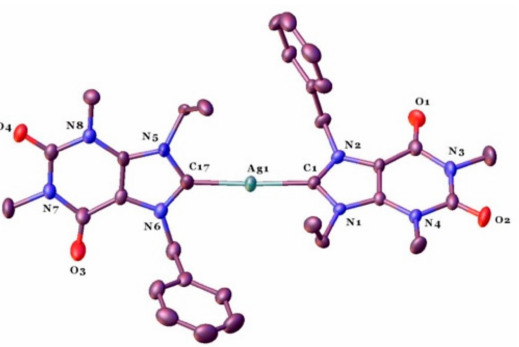
Figure 2. Molecular structure of compound 7 . Thermal ellipsoids are drawn at the 50% level. Hydrogen atoms and the PF 6 − anion have been omitted for